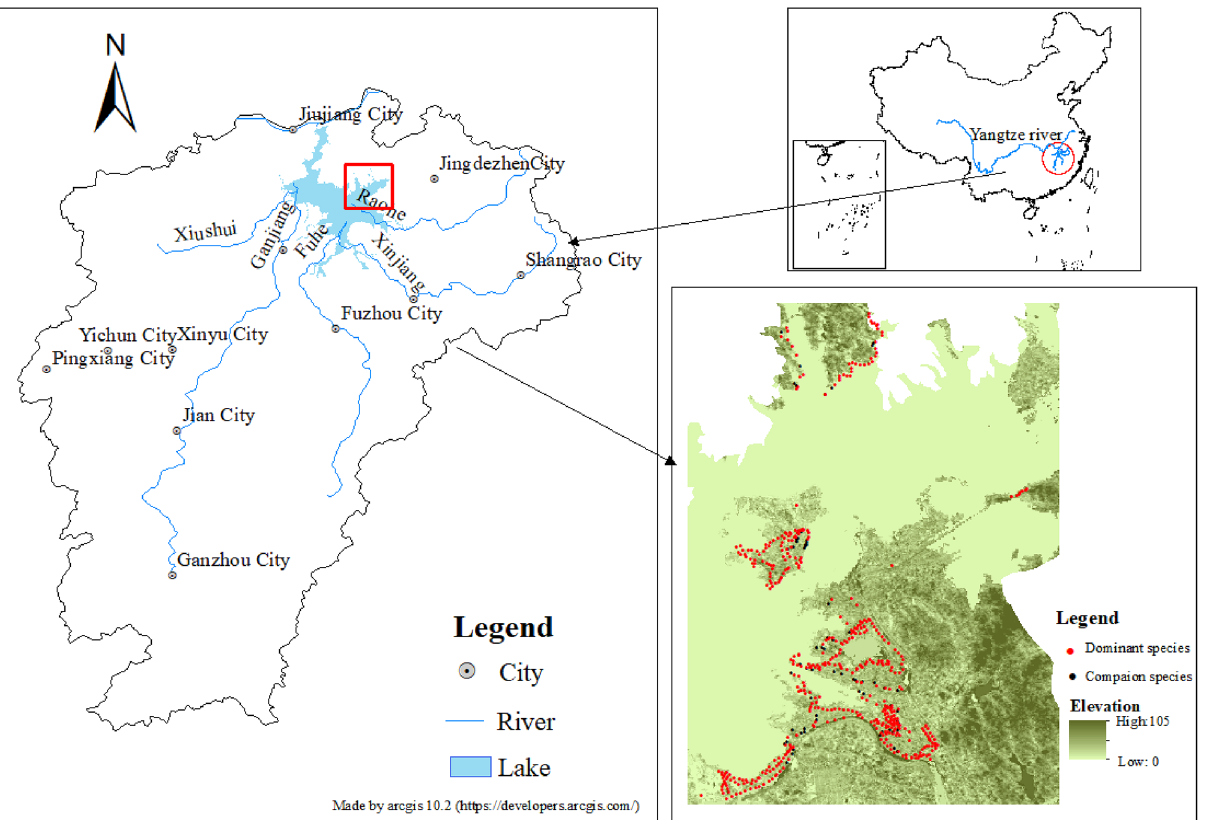
Figure 1. Location of Poyang lake, China and sampling point